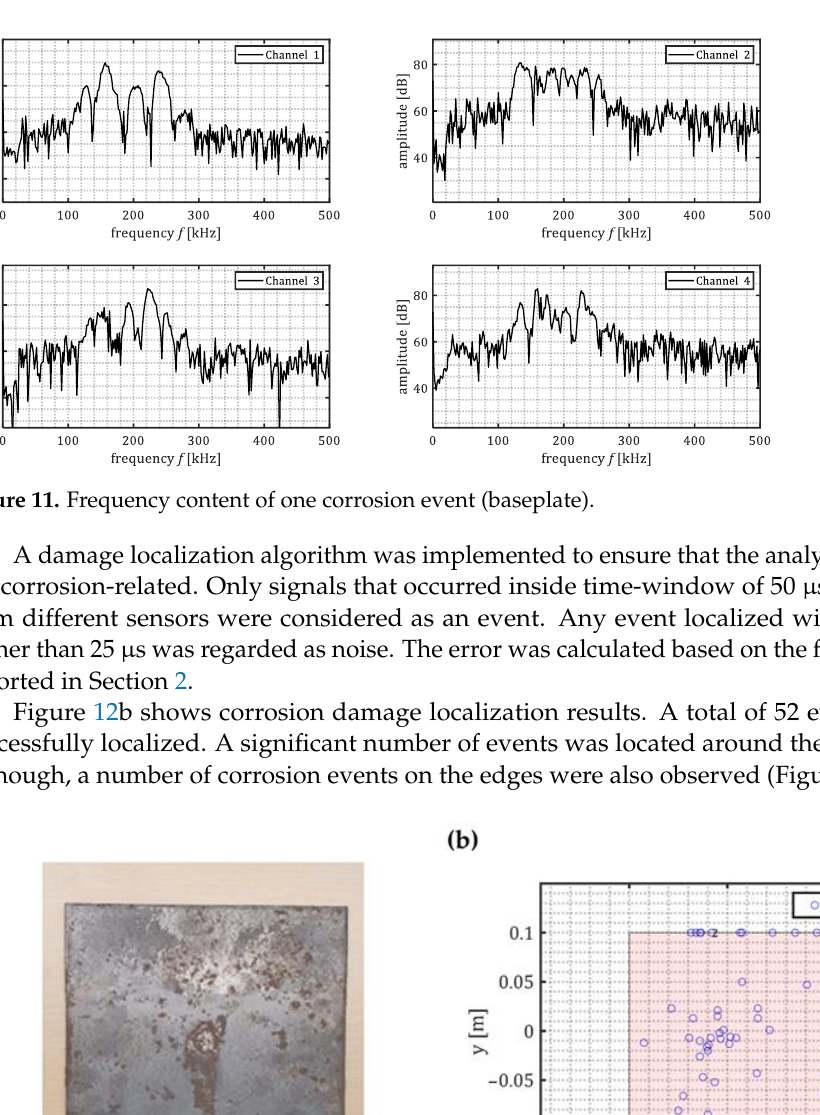
Figure 10. The corrosion induced signals for baseline plate experiment.